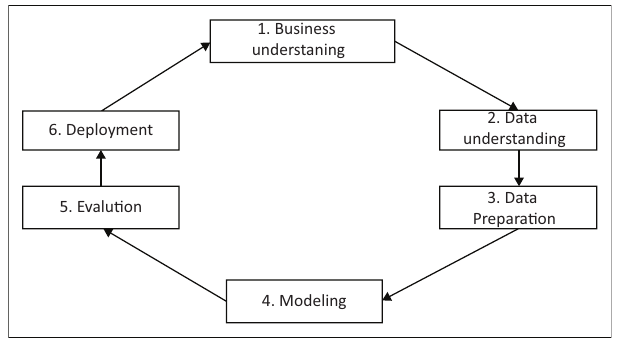
FIGURE 2: The cross-industry standard process for data mining (CRISP – DM) approach to data